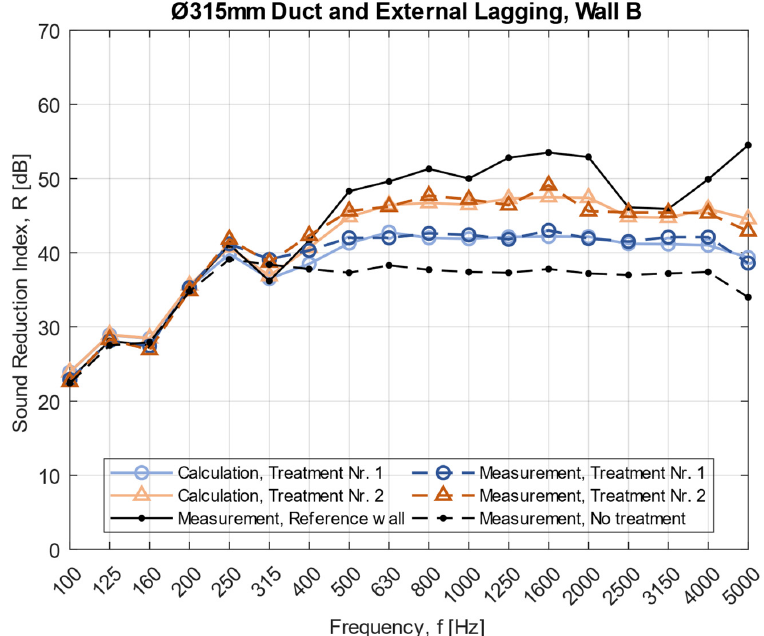
Figure A2. Theoretical models compared to measurements with external lagging as acoustic treatment. Ventilation duct with Ø315 mm through wall B with a sound reduction index of R w = 46 dB. External lagging is mounted at partial lengths of 0.6–1.2 m (Treatment 1 and 2) with 50 mm stone wool, density of 100 kg/m 3 , closest to the wall.